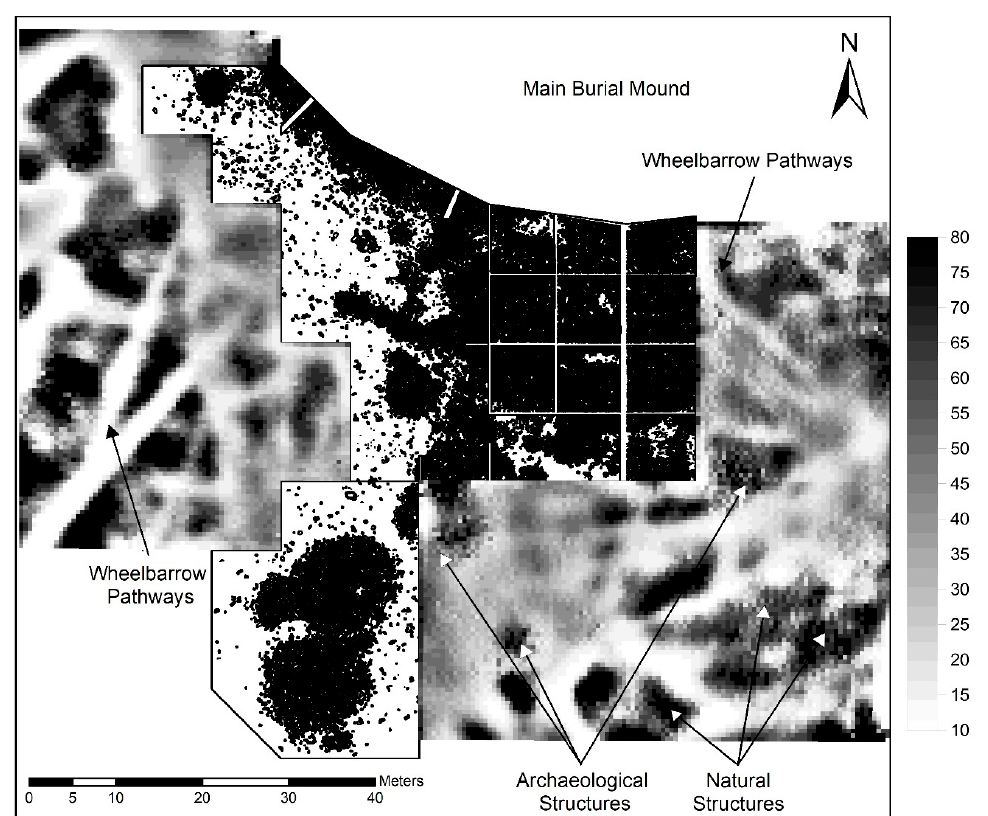
Figure 5. Results of the geoelectric resistivity survey (in Ω displayed in grayscale) and the plan of the 2018 excavation (in black and white) in the southern periphery of the main burial mound. Archaeological and natural structures show a very similar signature and can be confused easily. show the most obvious